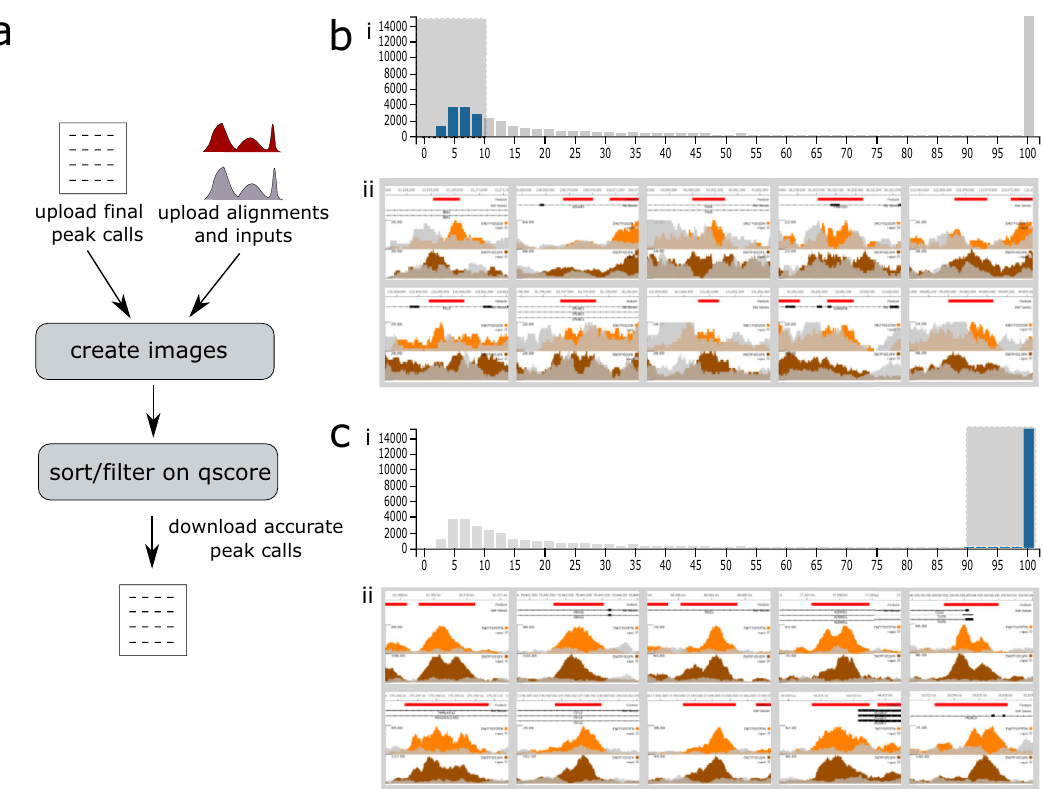
Fig. 1 Summary of peaks in encode project ENCSR391NPE. https://mlv.molbiol.ox.ac.uk/projects/multi_locus_view/1434 a Work fl ow (see supplementary methods 1 for full details). b Locations with − log 10 q values less than 10 have been selected using the histogram ( i ), clearly showing regions ( ii ) which are misidenti fi ed as peaks. c Locations with high − log 10 q values selected ( i ), showing genuine peaks ( ii ). The two alignment tracks ENCFF025ZEN and ENCFF421QFK are orange and brown respectively and the corresponding input tracks, ENCFF483ELD and ENCFF769UET are